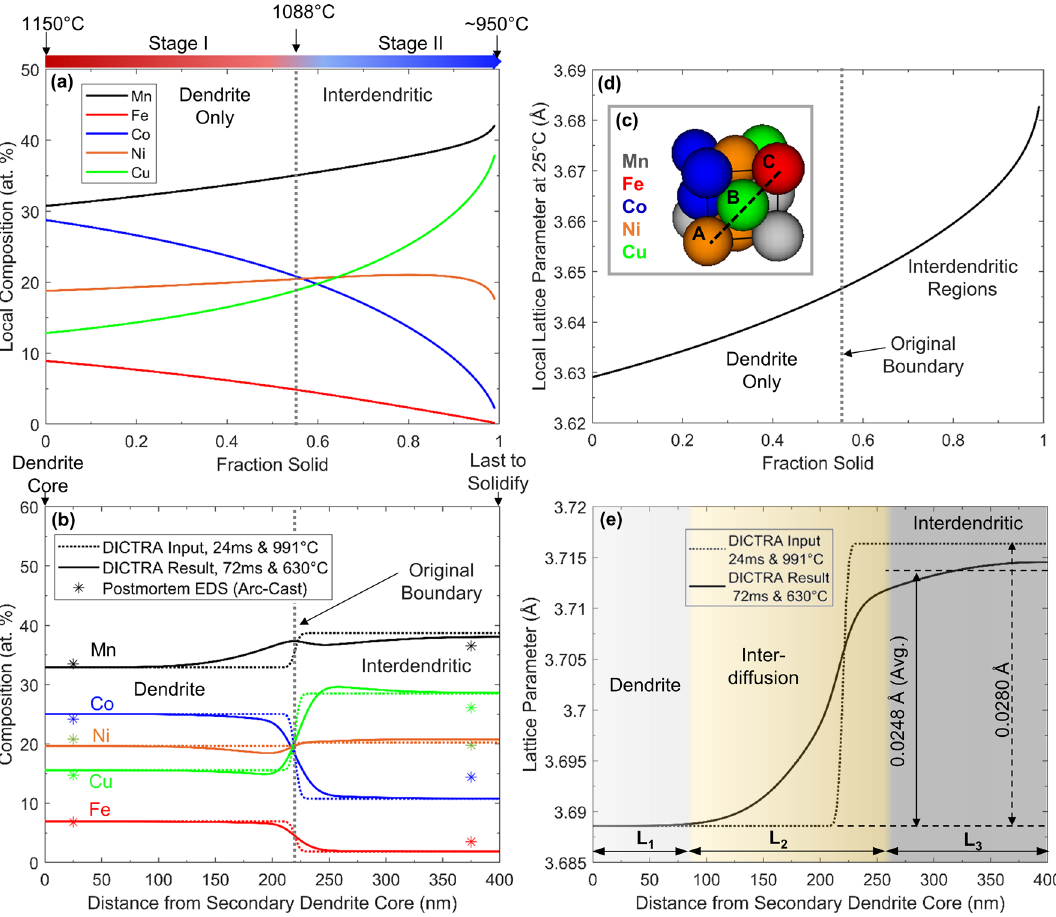
Figure 6. ThermoCalc simulation data for Mn 35 Fe 5 Co 20 Ni 20 Cu 20 MPCA: ( a ) Composition profiles directly output from Scheil simulation. ( b ) Composition profiles at the termination of Stage II used as DICTRA inputs (dotted lines), and the profiles output from DICTRA at the termination of Stage III (solid lines). Final composition estimates from EDS performed on arc-cast material are displayed as stars. ( c ) Hard-sphere rendering of an example MPCA unit cell, illustrating the conversion from composition to lattice parameter (Eq. 3). ( d ) Lattice parameter profile matching the compositions in ( a ). ( e ) Lattice parameter profiles matching ( b ), including the profile at the end of Stage II (dotted line), and the profile at the end of Stage III (solid line). For simplicity, the profiles are compared at the temperature at the termination of Stage III. The dendrite (L 1 ), interdiffusion (L 2 ), and interdendritic (L 3 ) regions identified correspond with the profile following Stage